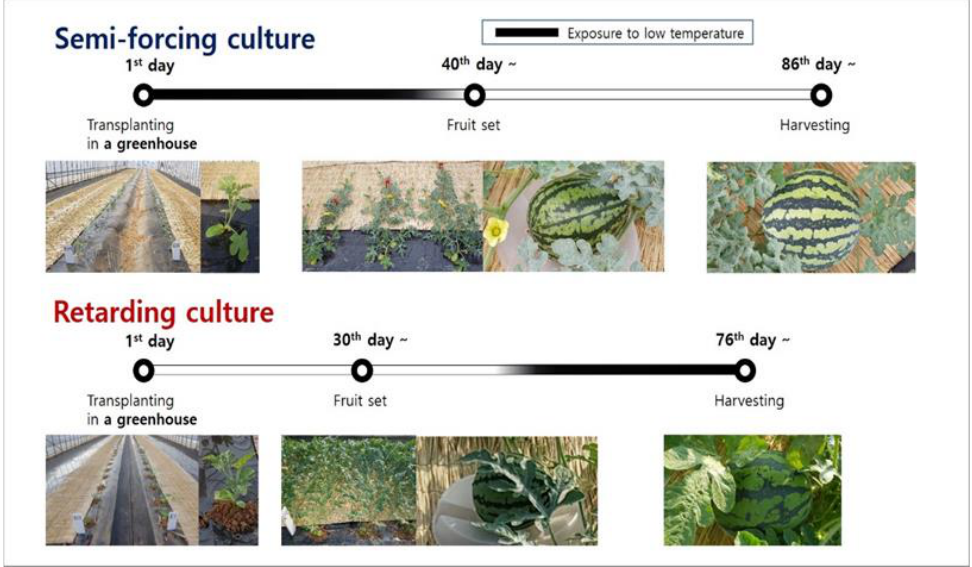
Figure 1. Cultivation schedule in semi-forcing (April to June) and retarding culture (August to Oc- tober).